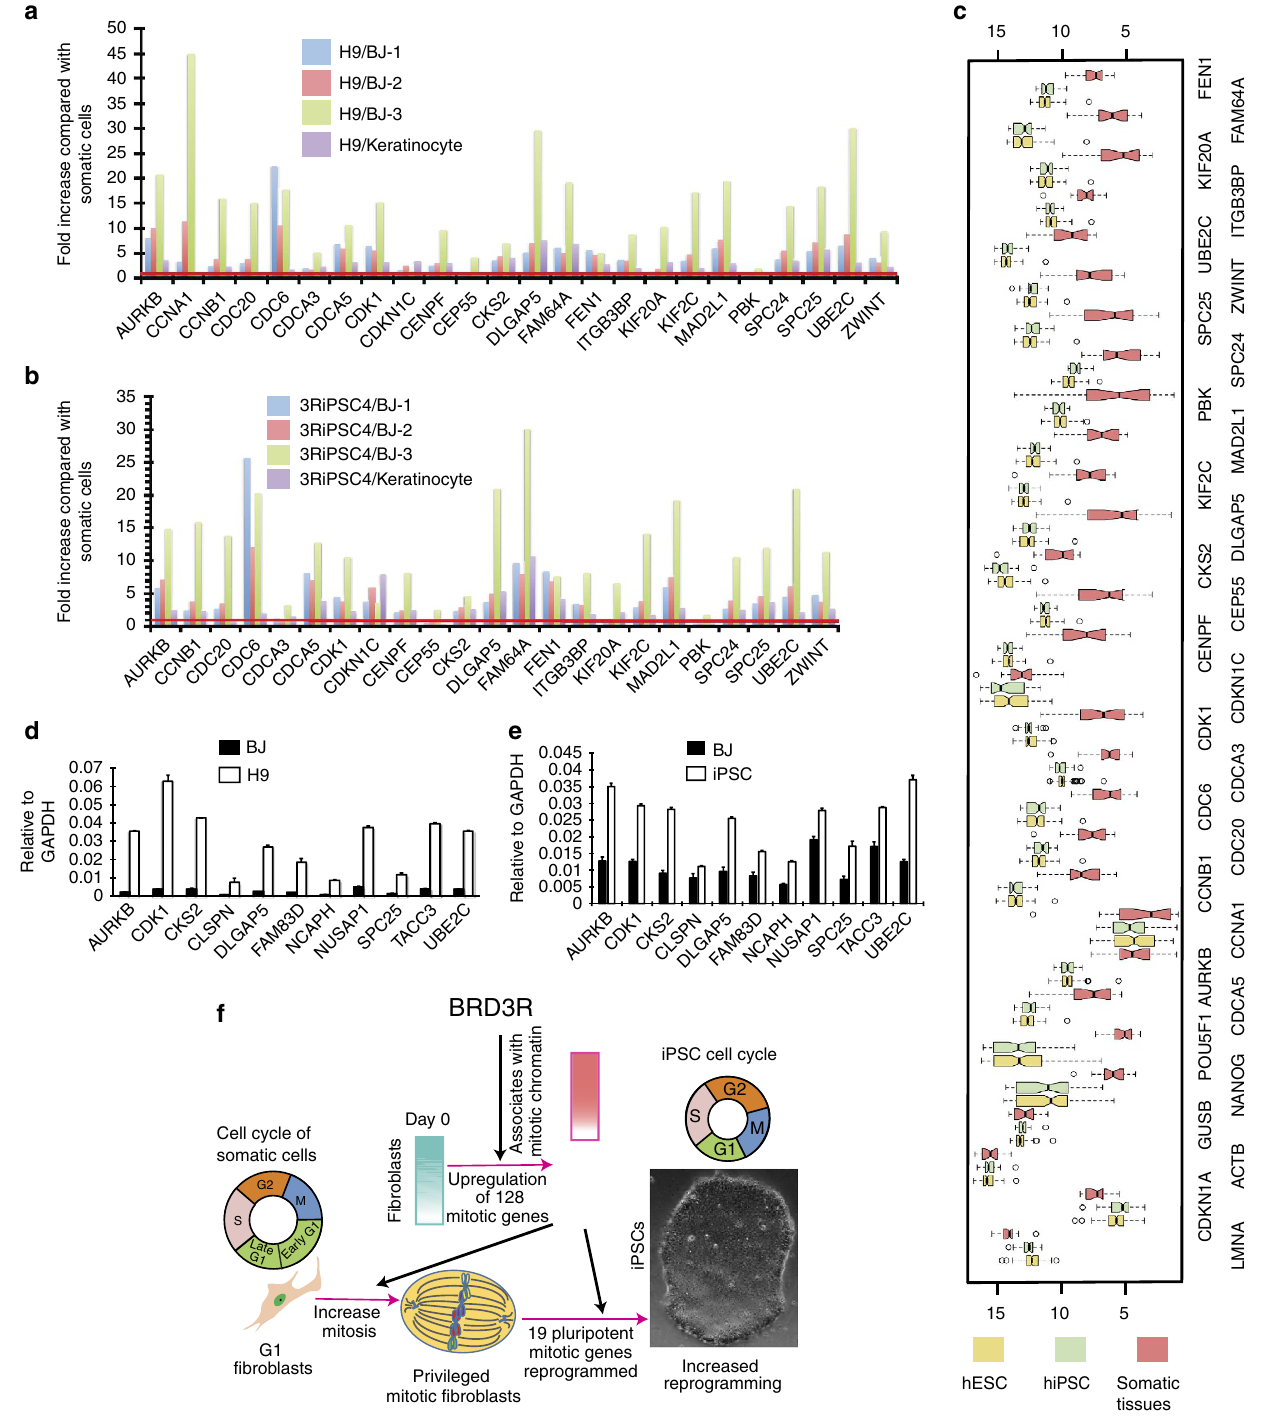
Figure 7 | BRD3R-upregulated mitotic genes constitute a PSC fingerprint. ( a , b ) Fold enrichment of the 24 BRD3R-regulated mitotic genes in human embryonic stem cells. ( a ) and human iPSC ( b ) as compared with 3 BJ samples and one keratinocyte (based on RNA-Seq). Red line, no-change level. ( c ) Box plots showing higher expression levels of the 24 BRD3R-regulated mitotic genes in human PSC compared with 20 human tissues, based on dataset GSE34200. Left and right box border represent 75 and 25%, and middle vertical lines indicate the median value. Whiskers indicate the upper and lower extremes. ( d , e ) RT–qPCR verification of the upregulation of the BRD3R-regulated mitotic genes in human pluripotent cells (11 randomly selected genes from the list of 185 mitotic genes upregulated by BRD3R on day 3 of reprogramming; mean ± s.d., n ¼ 3). ( f ) Model for BRD3R modulation of reprogramming process. Overexpression of BRD3R upregulates a great number of mitotic genes, and results in increased mitotic activity privileged for reprogramming. BRD3R regulation of mitosis contributes to the enhanced reprogramming efficiency. BRD3R also facilitates the resetting of the PSC cell cycle structure. The gradient turquoise box indicates lower expressions of a set of mitotic genes in the starting fibroblasts; the gradient magenta box designates the elevated expressions of the mitotic genes in BRD3R-expressing reprogramming cells. Red arrows indicate a change from one state to another; black arrows represent positive